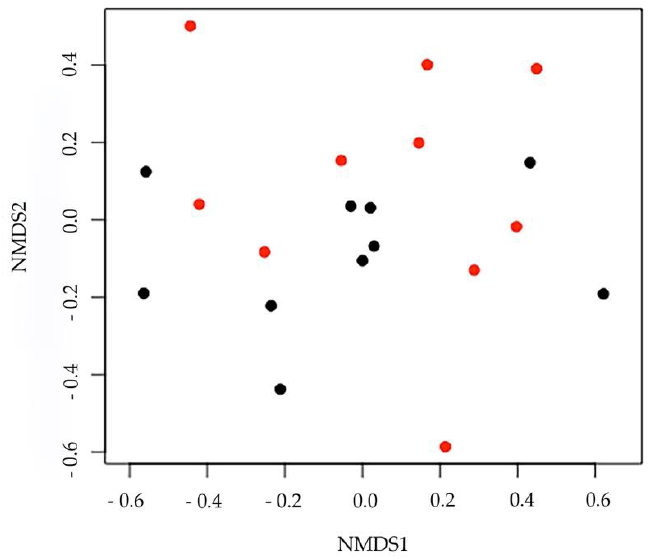
Figure 4. Bar plots showing the 10most abundant bacterial genera. We represented the ASVs > 1% among the 10most abundant bacterial genera. Each column represents a sample.